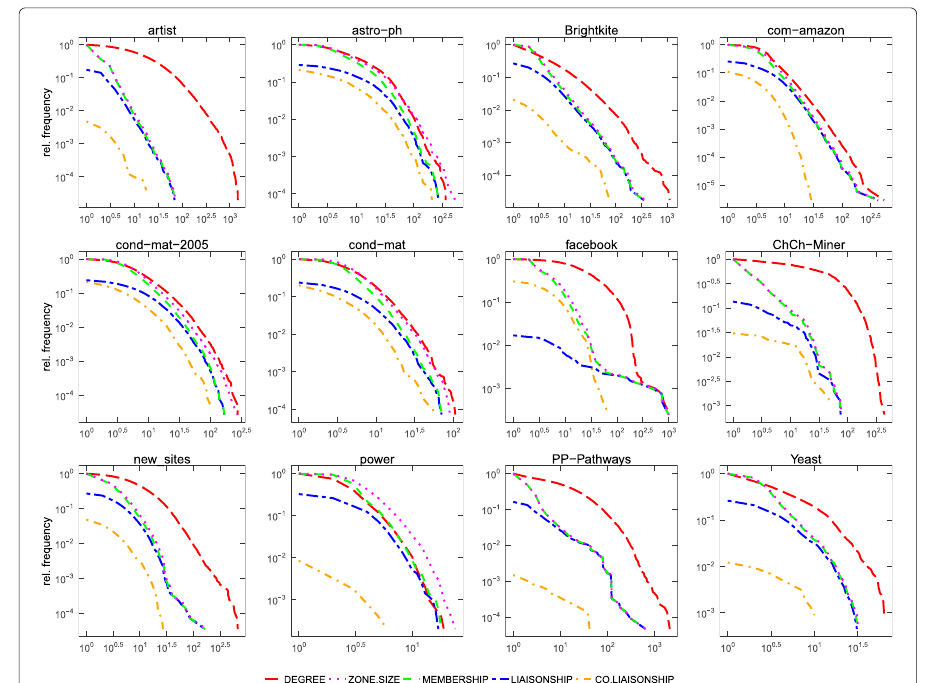
Fig. 21 Node and zone properties in real-world networks